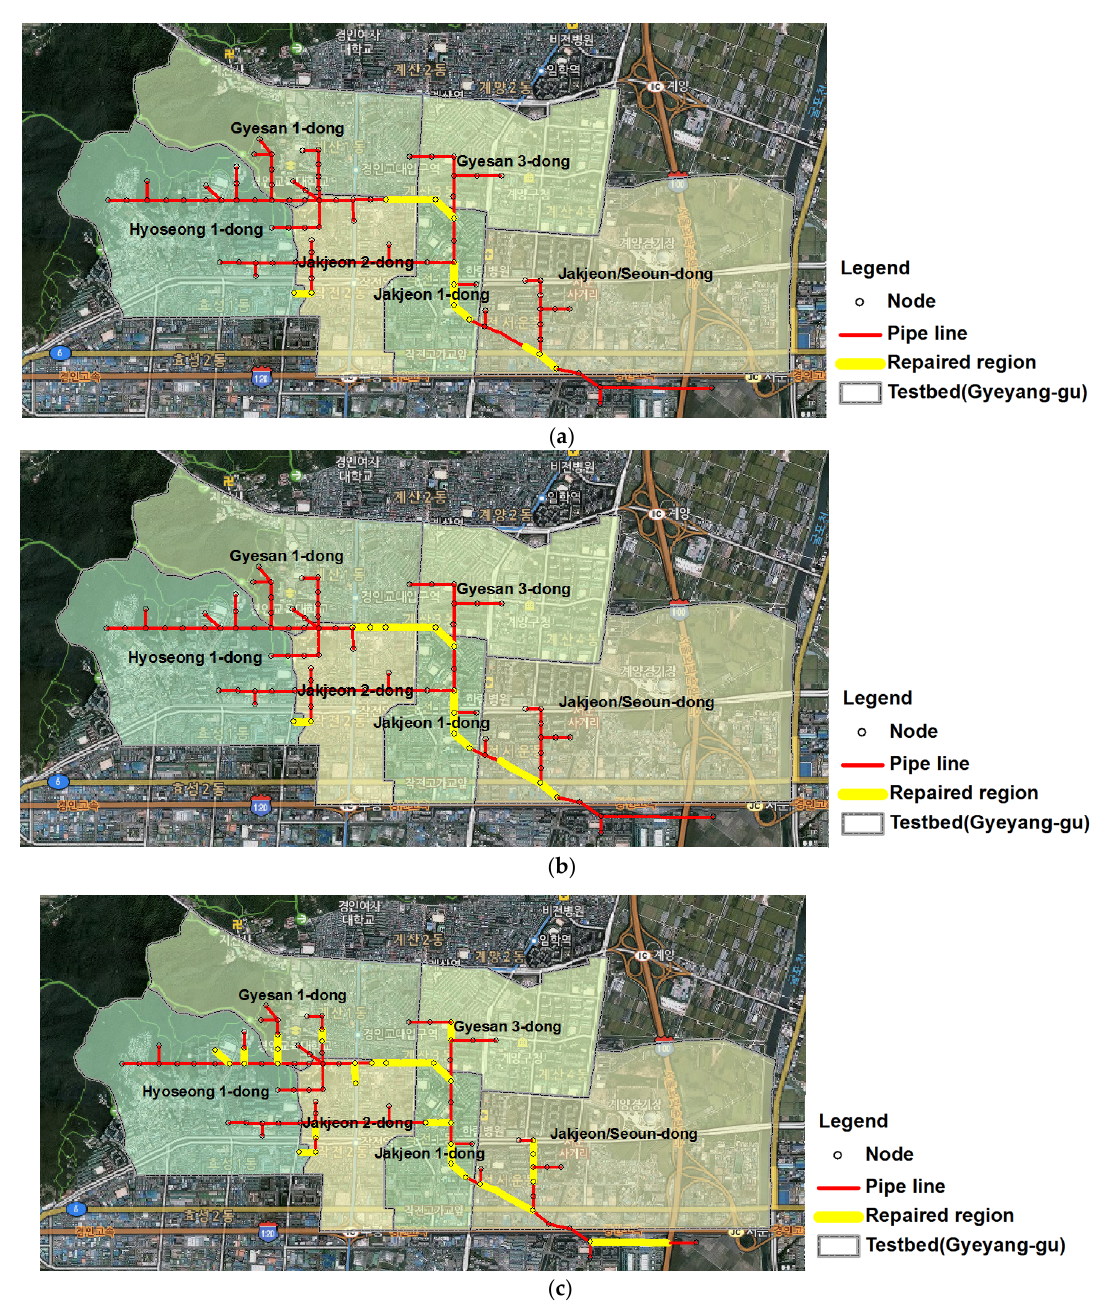
Figure 9. Sections with insufficient capacity. ( a ) Future I (2020s); ( b ) Future II (2050s); ( c ) Future III (2080s).